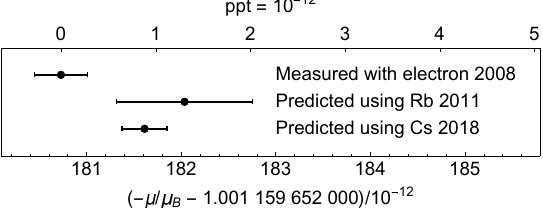
Figure 2. Comparison of the measured electron magnetic moment with the standard model predictions that use the two independent measurements of α that have the lowest